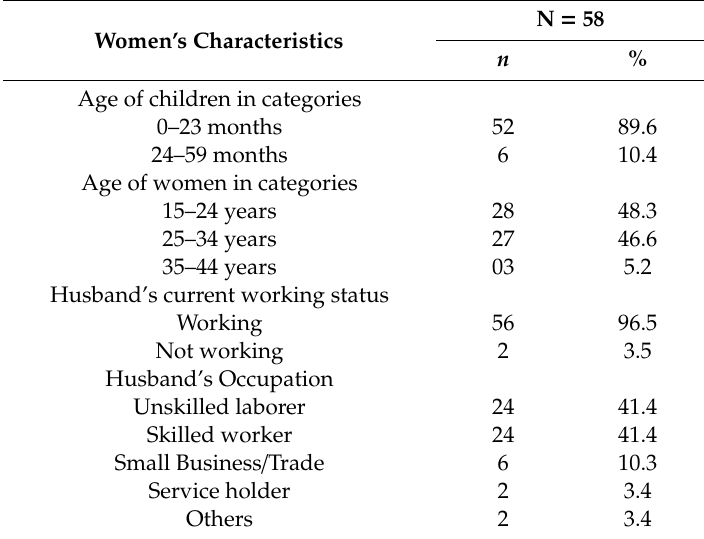
Table 2. Characteristics of the women participated in this study (N = 58).